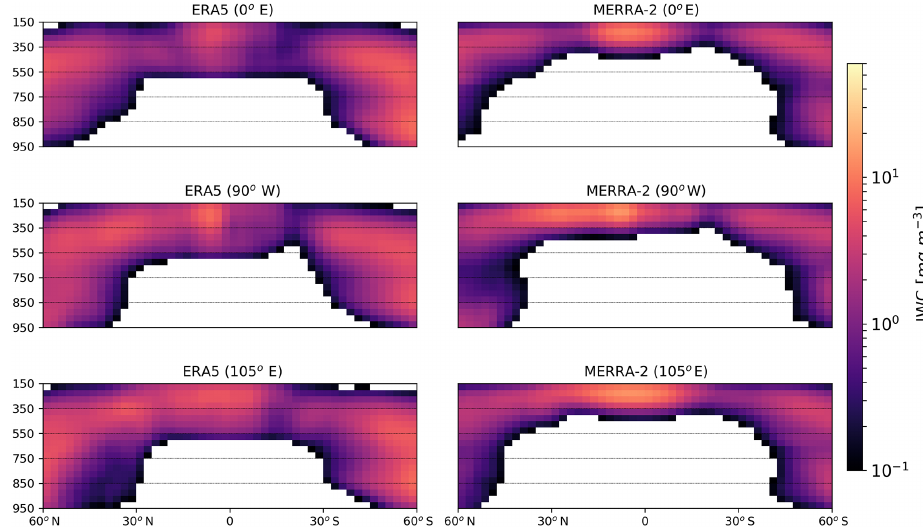
Figure 6. As in Fig. 4 but for non-precipitating cloud ice from the ERA5 and MERRA-2 reanalyses. Values below 0.1mgm − 3 are in white.